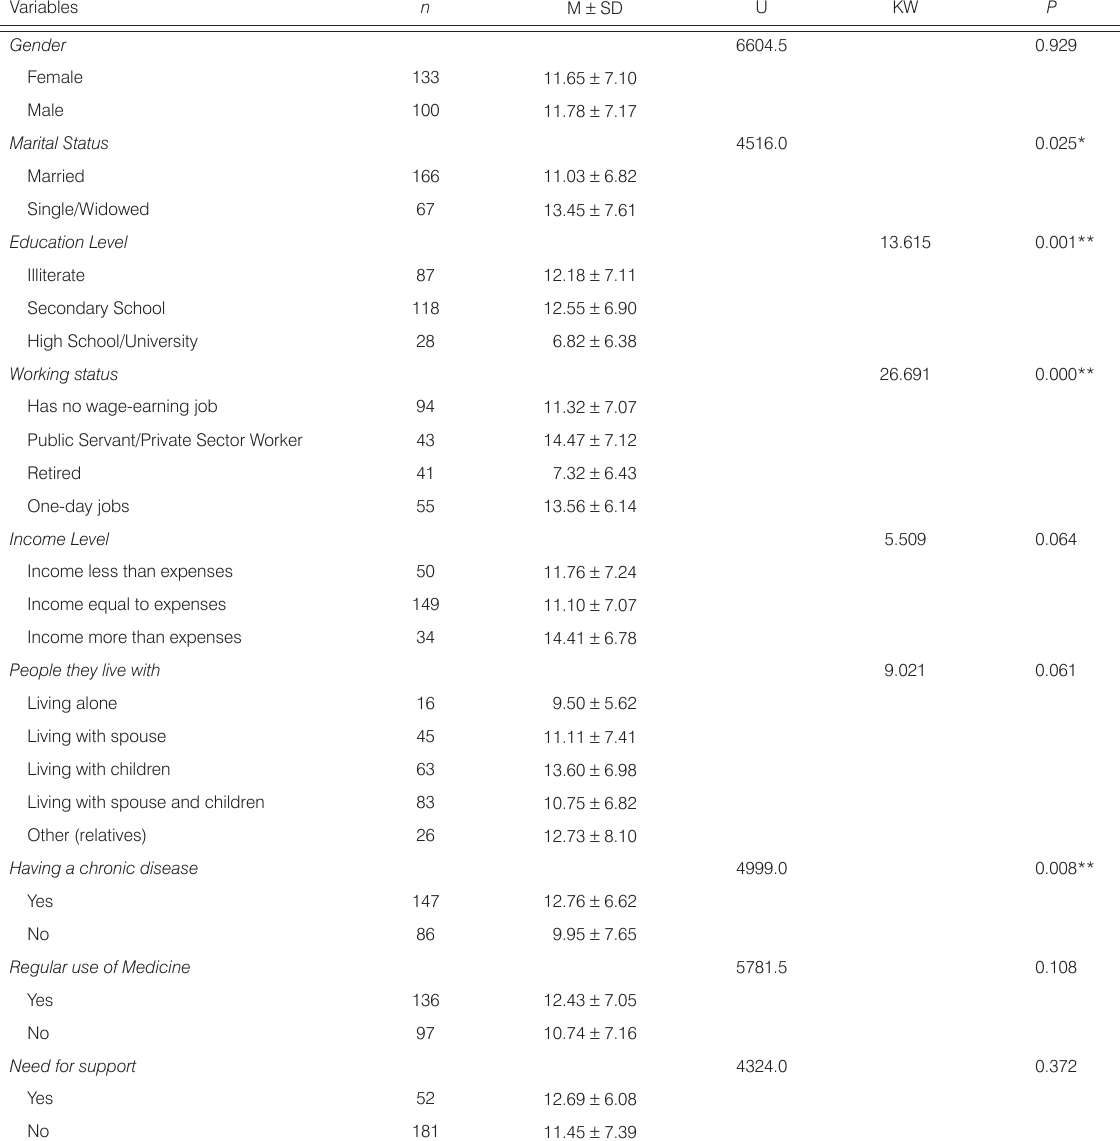
Table 3. The Participants’ DENN fall Risks Assessment Scale scores distributions according to socio-demographic characteristics ( n =